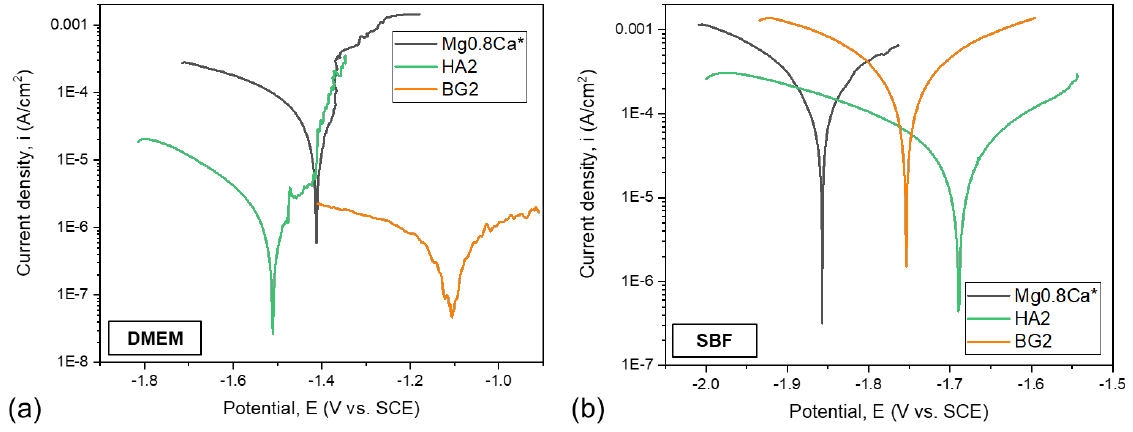
Figure 7. Tafel plots of the bare and HA2- and BG2-coated Mg-0.8Ca specimens immersed in ( a ) DMEM and ( b ) SBF testing media. * Mg-0.8Ca Tafel plots inserted from